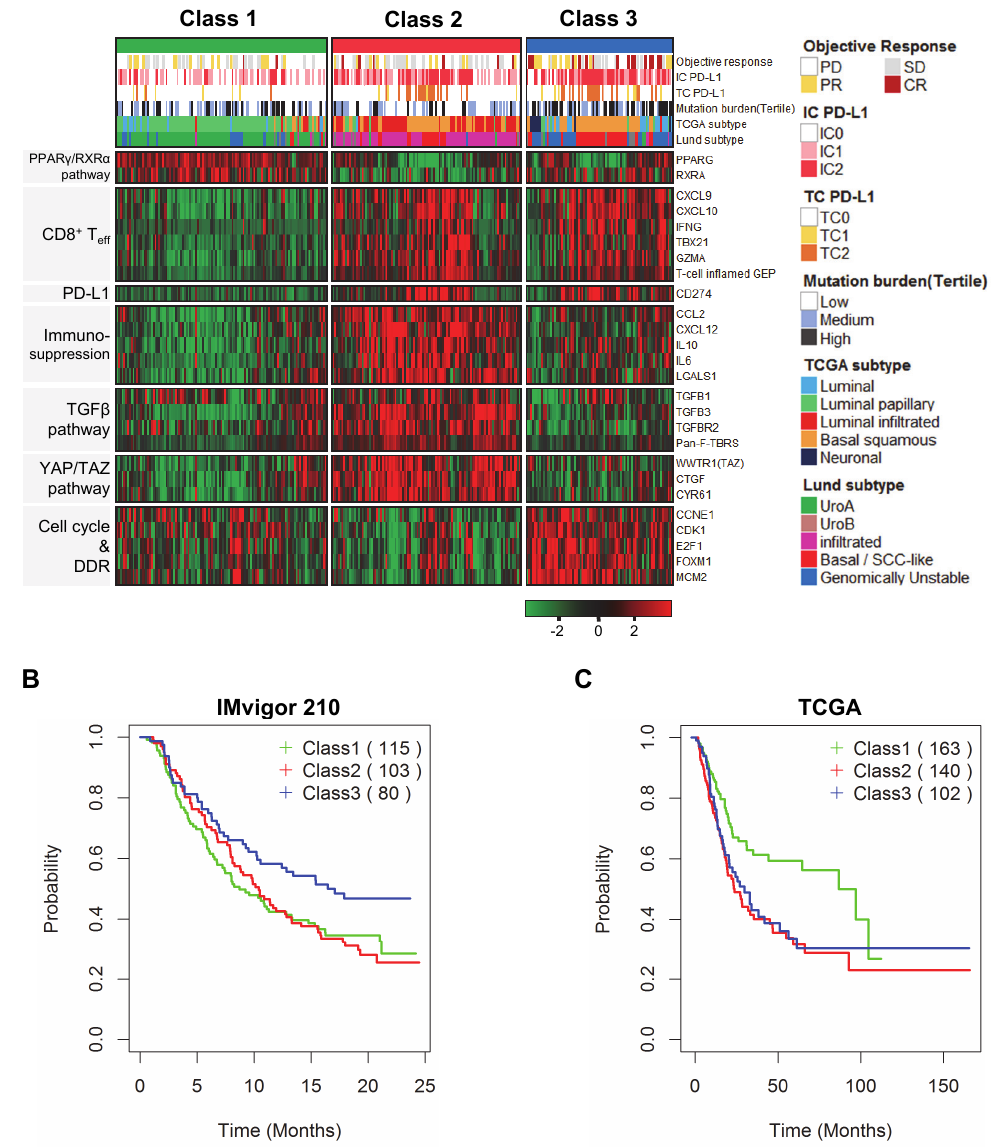
Figure 1. Core biological pathways associated with immune checkpoint inhibitor (ICI) therapy in the IMvigor 210 cohort and survival analyses. ( A ) Heat map of immunotherapy-associated clinical and biological features. On top , samples are ordered according to gene expression patterns. Gene signatures, including the pan-fibroblast TGF β response signature (pan-F-TBRS) and the T cell inflamed gene expression profile (GEP) scores, were selected to explore the correlation between expression patterns and other relevant biological processes. Gene expression levels and signatures such as the Pan-F-TBRS and GEP were ordered and grouped by pathway. The coloring in the heat map reflects relatively high (red) and low (green) expression (Z score) levels; the same representation is used for high and low gene signatures. T e ff , T e ff ector. ( B ) Overall survival in the IMvigor 210 cohort ( p = 0.04 by the log-rank test). ( C ) Overall survival in the TCGA cohort ( p = 0.001 by the log-rank